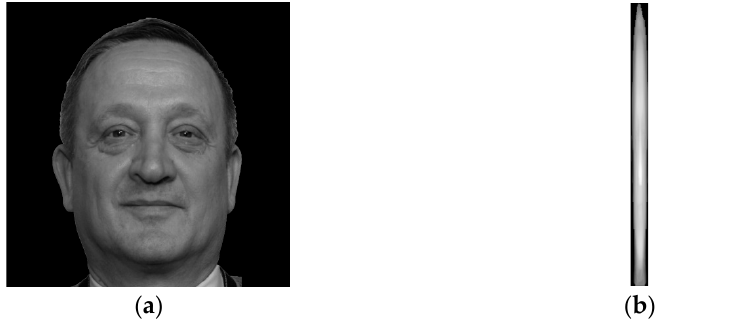
Figure 16. The frame of the 3D image: ( a ) texture (2000 × 2000 pixels); ( b ) the pattern of structured fringes (25 × 2000 pixels).